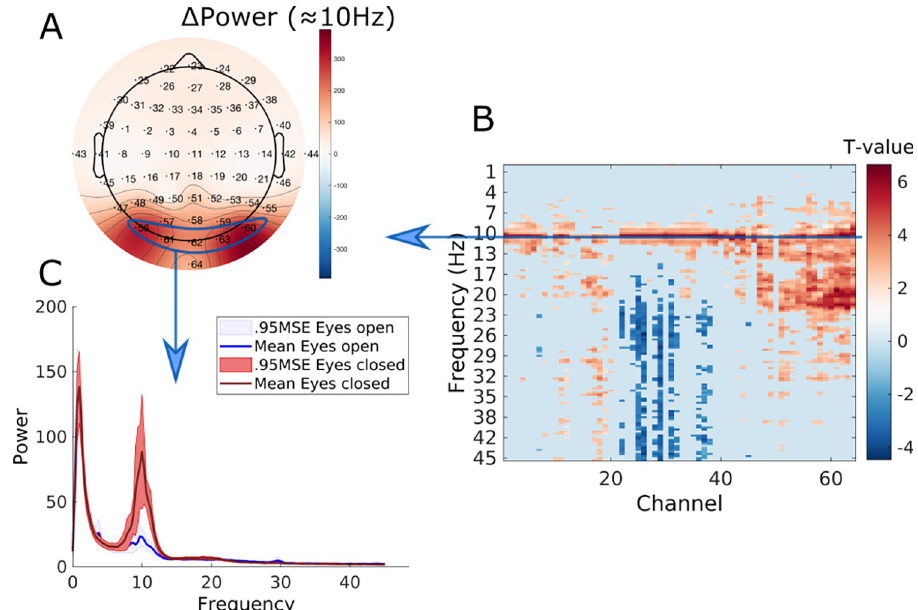
Fig 2. Results of the power spectral analysis. Panel A shows the topographic plot of the mean power difference ( Δ Power; power = Db/frequency)) at 10.6 Hz. The FDR-thresholded t-values of all Channels x Frequencies are shown in image format in panel B. The mean power spectrum and 0.95 standard error intervals about the mean over channels PO7, Oz, O2 and PO8 for EO and EC are plotted in panel C.